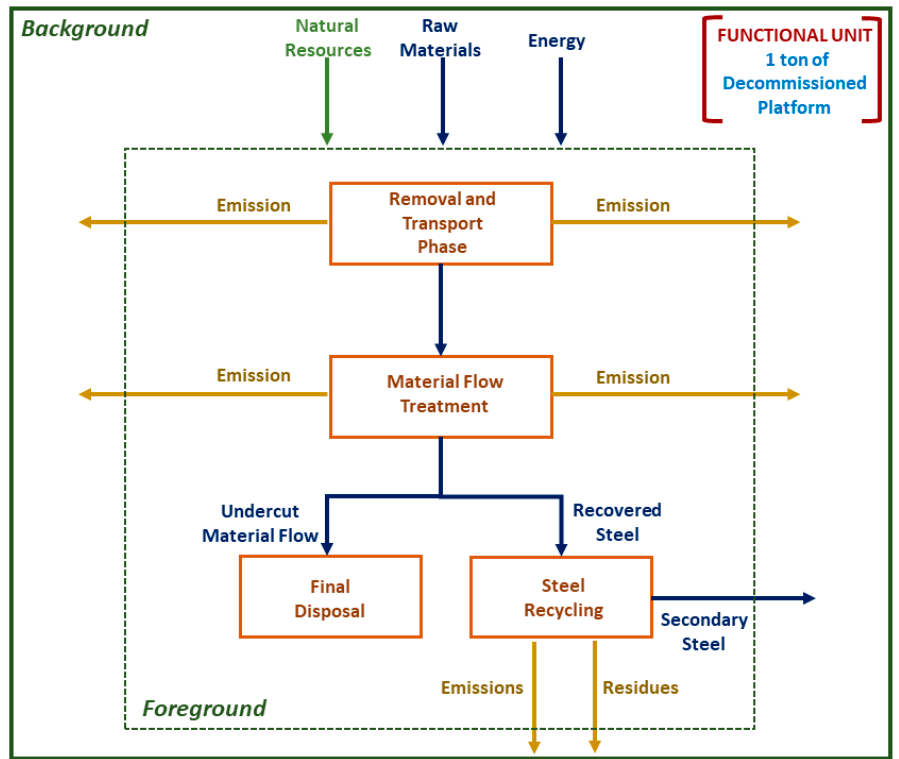
Figure 2. Background and foreground systems under study.